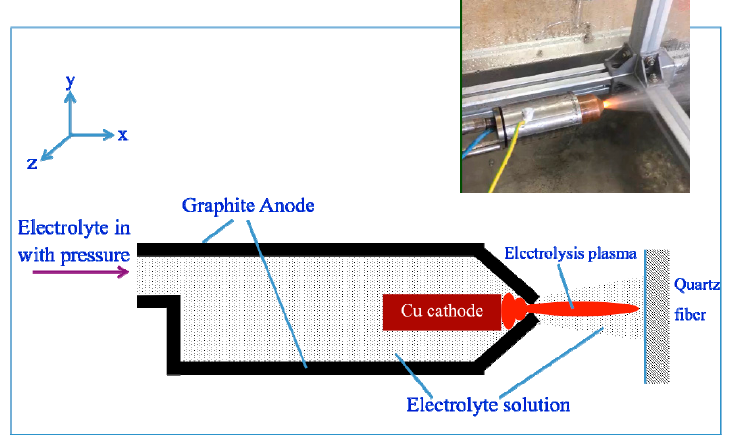
Figure 1. The schematic diagram of the experimental process with the spraying photo shown in the